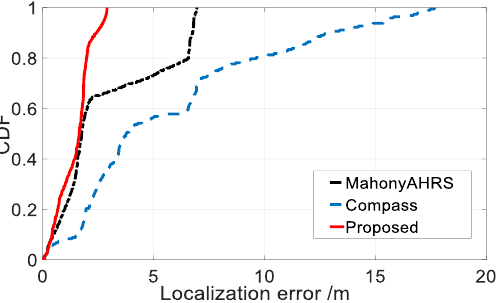
Figure 9. Localization accuracy comparison of PDR using different heading estimation algorithms.